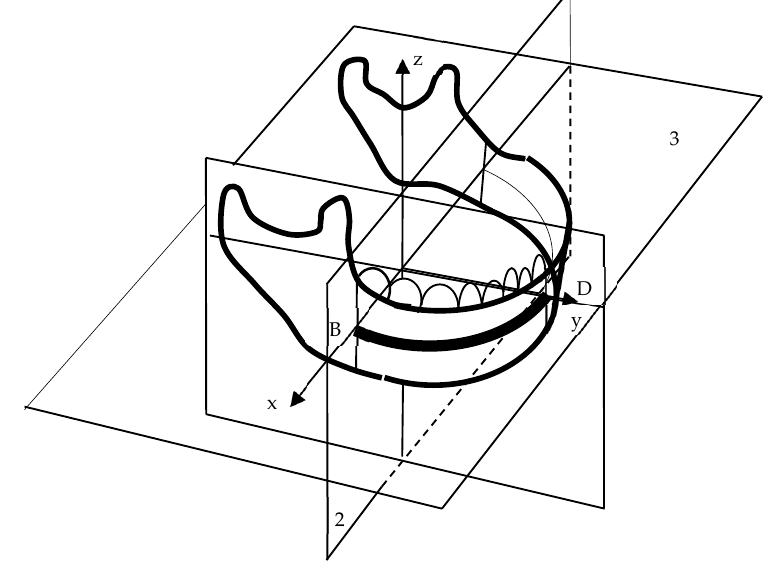
Figure 1. Mandible body separated with two planes.